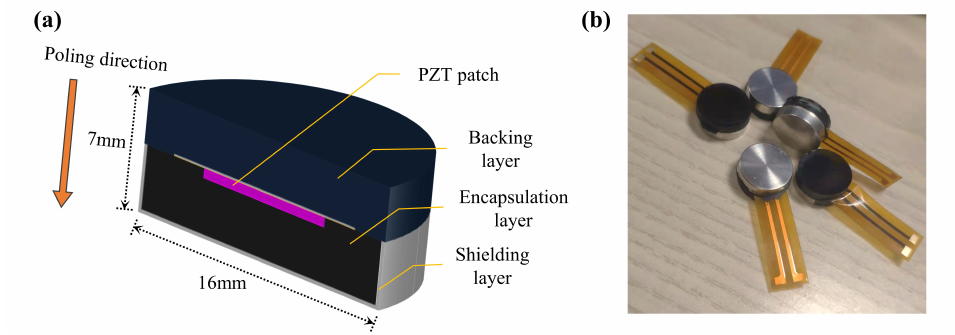
Figure 1. ECPT: ( a ) structure of ECPT; ( b ) the finished product of ECPT.